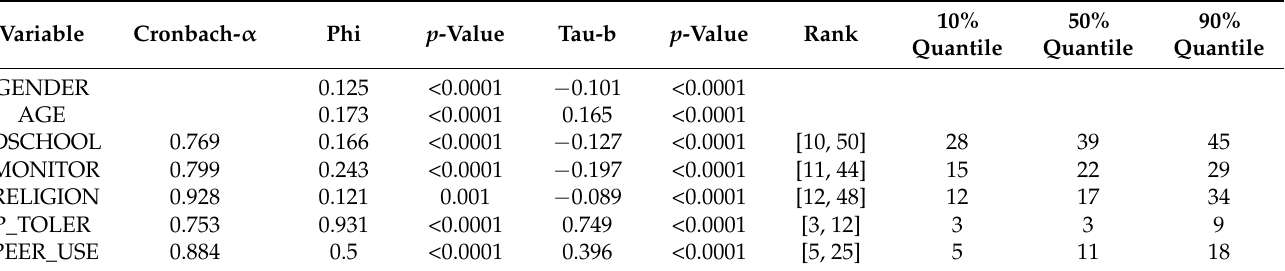
Table 4. Cronbach’s alphas of scales, measures of association between independent variables and use, and 10, 50, and 90% quantiles of the variables: DSCHOOL, MONITOR, RELIGION, P_TOLER, and PEER_USE.